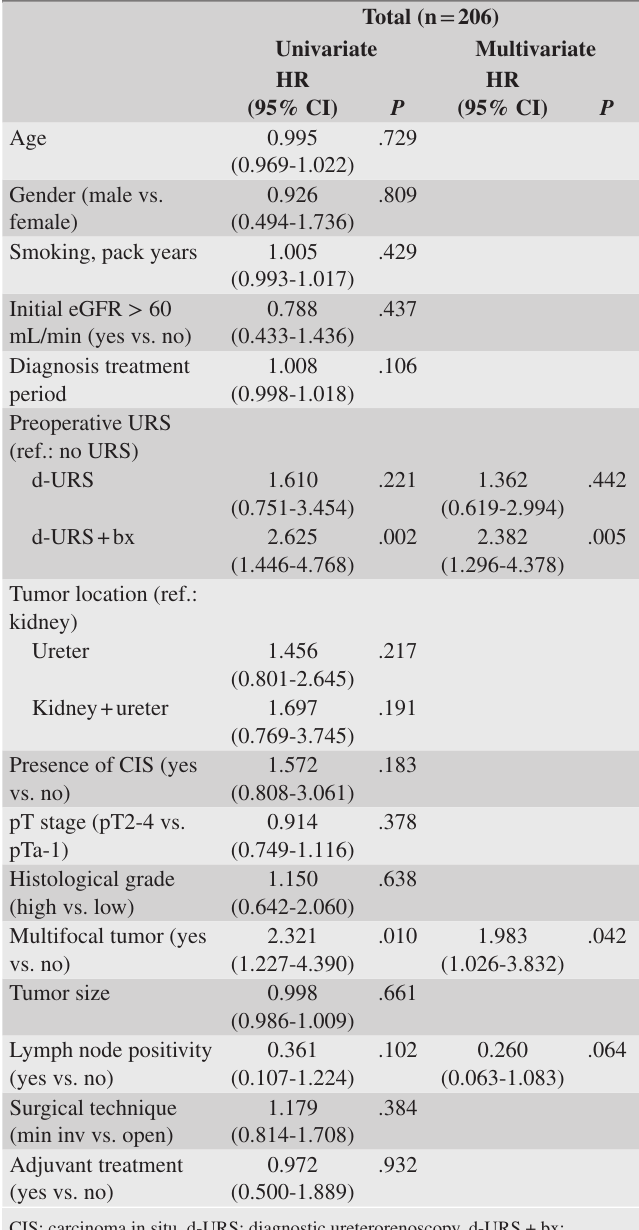
Table 2. Univariate and Multivariate Cox Proportional Hazards Regression Analysis to Determine the Factors That Were Associated with Intravesical